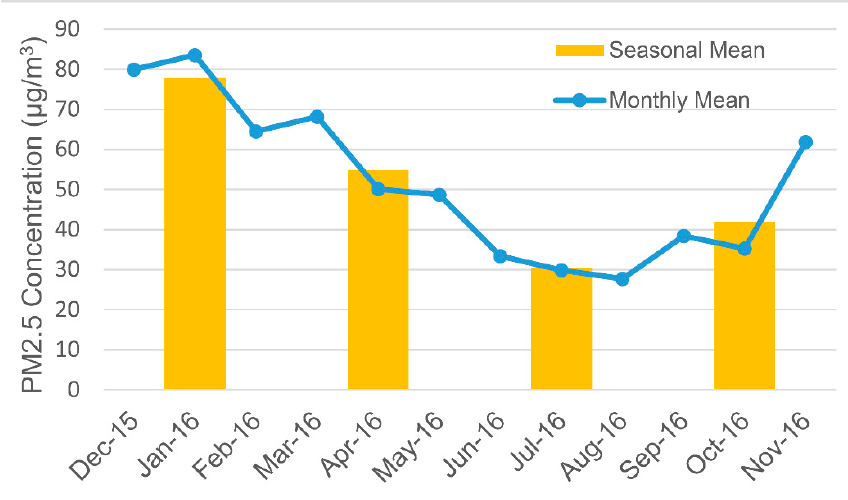
Figure 3. Seasonal and monthly mean PM 2.5 concentrations calculated from ground observations.